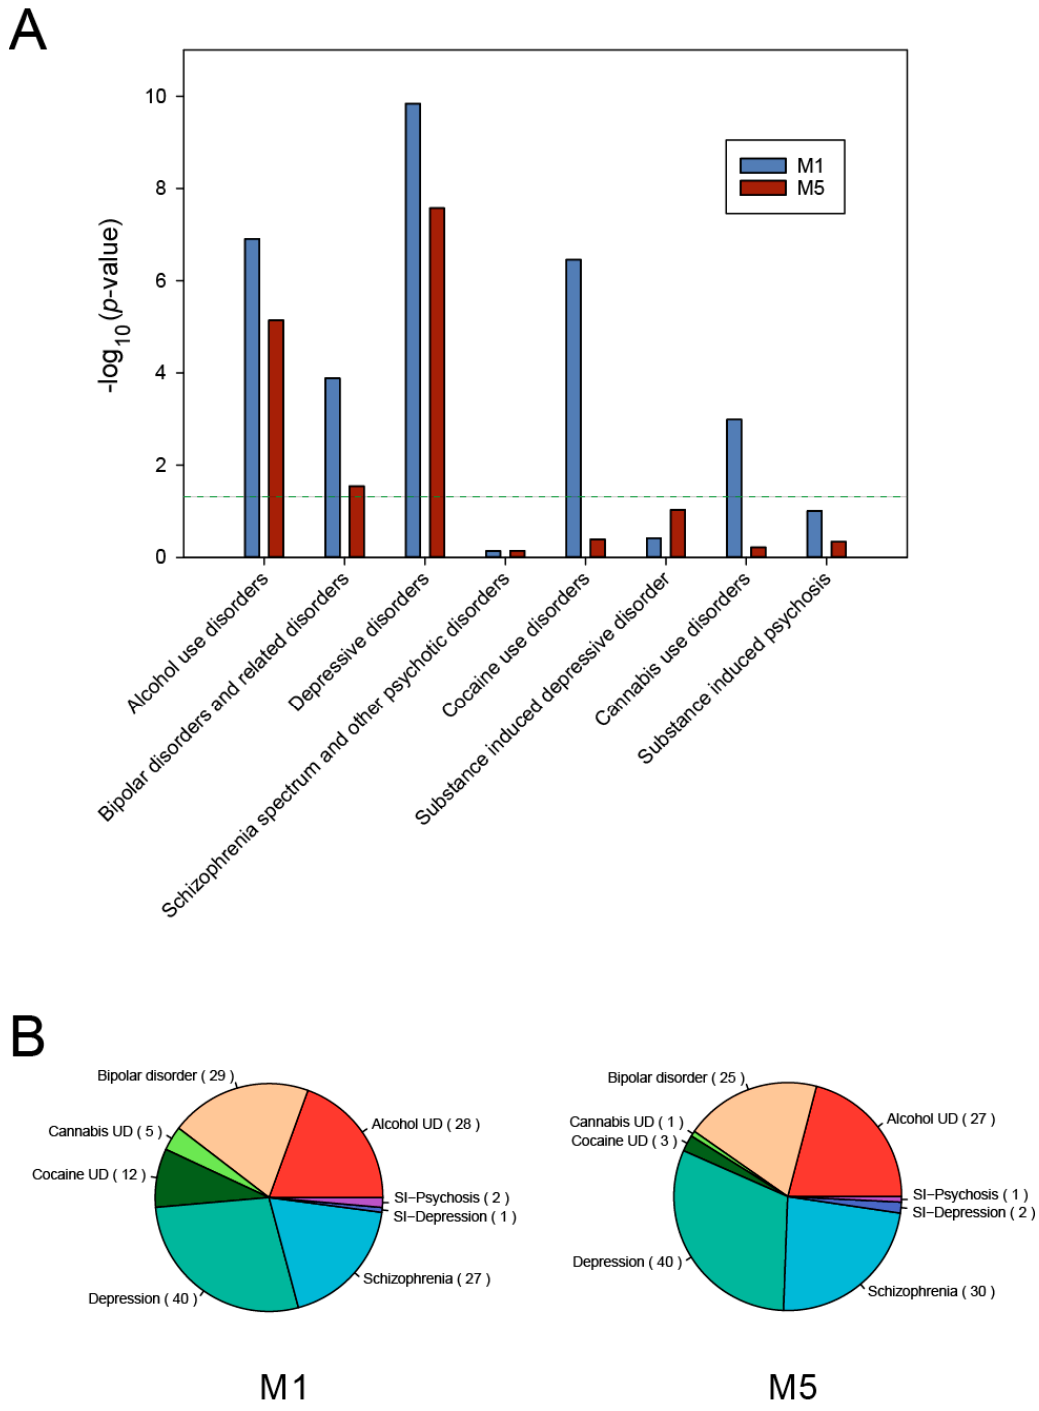
Figure 4. Psychiatric disease association of the delirium-related M1 and M5 modules. ( A ) Disease association analysis for the eight classes of psychiatric disorders. The analysis was performed by using the R psygenet2r package. The enrichment of disease-associated genes was tested by using the hypergeometric distribution test, and results with p -values less than 0.05 were considered as statistically significant. The dashed line indicates p = 0.05. ( B ) The distribution of genes associated with PsyGeNET disease categories between the M1 and M5 modules. The number in parentheses represents the associated genes in each module (SI, substance induced; UD, use disorders).